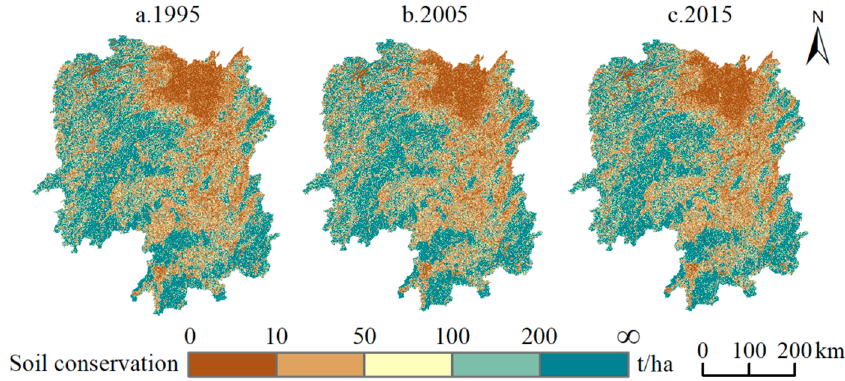
Figure 4. Spatial distribution of soil conservation in Hunan province, 1995–2015.